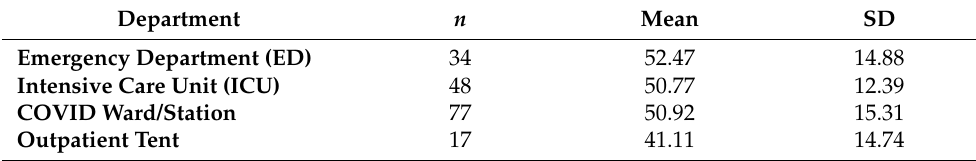
Table 14. Differences in the means according to the variables of the department for the Stress